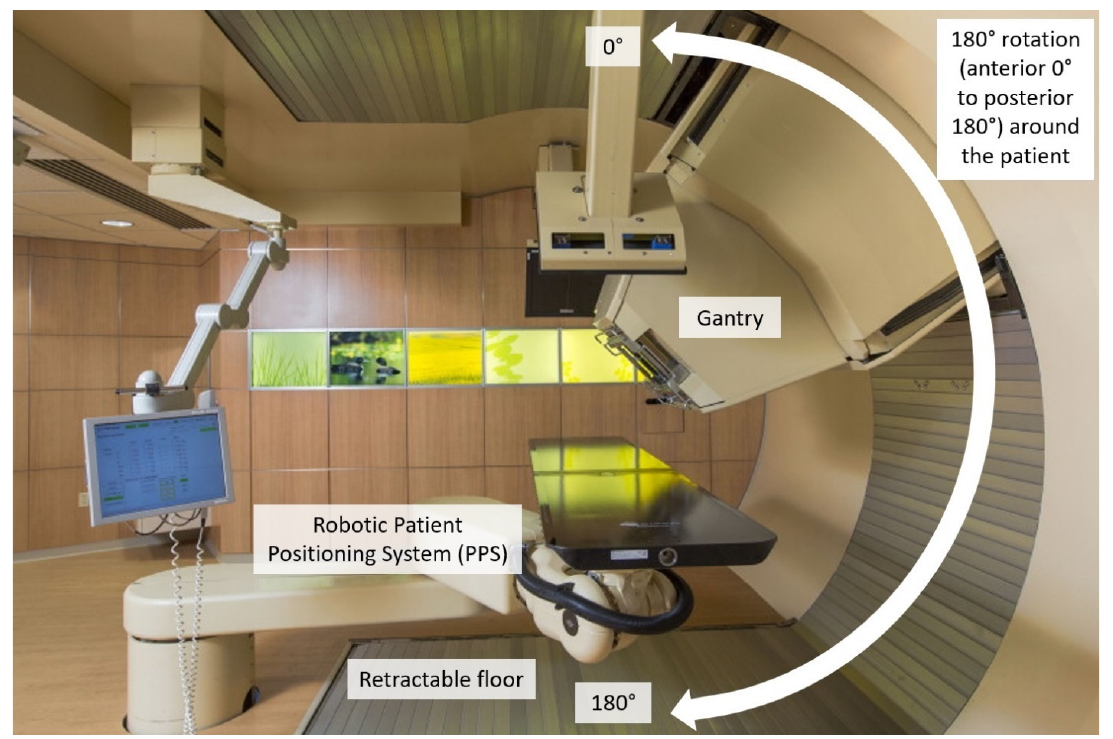
Figure 1. Photograph of the proton therapy treatment delivery system which consisted of a 190° rotating gantry with a six ‐ degree ‐ of ‐ freedom robotic patient positioning system capable of rotating greater than 180° to facilitate both left ‐ and right ‐ sided beam angles (Hitachi, ProBeat V, Tokyo, Japan). For treatment planning and delivery, 360 beam angles are available to choose from. A rotation of 0° corresponds to an anterior beam in a supine patient orientation. A rotation of 180° corresponds to a posterior beam in a supine patient orientation.